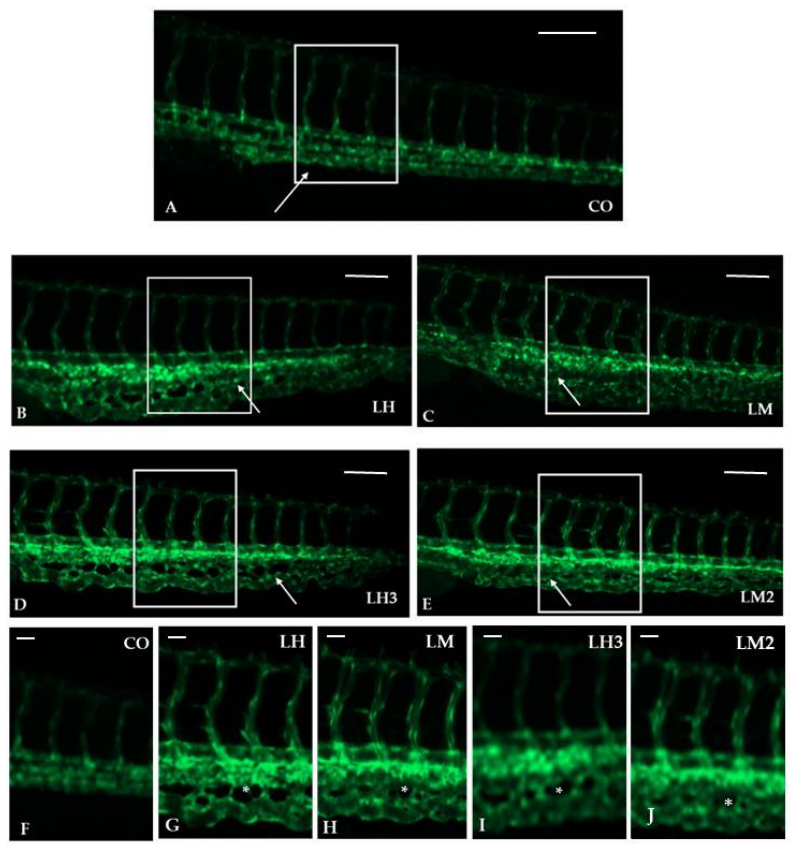
Figure 3. Purified extracts from H. aspersa caused pro-angiogenetic effects on ISVs and intercapillary spaces in the CVP: ( A – E ) Representative images of zebrafish trunk ISVs of controls (fish water and 0.1% DMSO) ( A ) and treatments with 10 µg/mL of LH ( B ), LM ( C ), LH3 ( D ), and LM2 ( E ). All figures are lateral views with dorsal to the top and anterior to the left, and fluorescent vessels of embryos were observed at 48 hpf. White arrowheads indicate the CVP, showing an increase in the angiogenesis process. Enlarged white boxes indicate the magnification of ISVs and CVPs ( F – J ). Asterisks (*) indicate the intercapillary spaces. The experiments were repeated twice. Images were taken with a Zeiss LSM 510 META confocal laser scanning microscope (Carl Zeiss, Jena, Germany), using an objective Achroplan 10 × and 20 × /0.25 and a 488 nm laser, and represent 1 embryo out of 30 with the same phenotype (for more details, see Section 2).